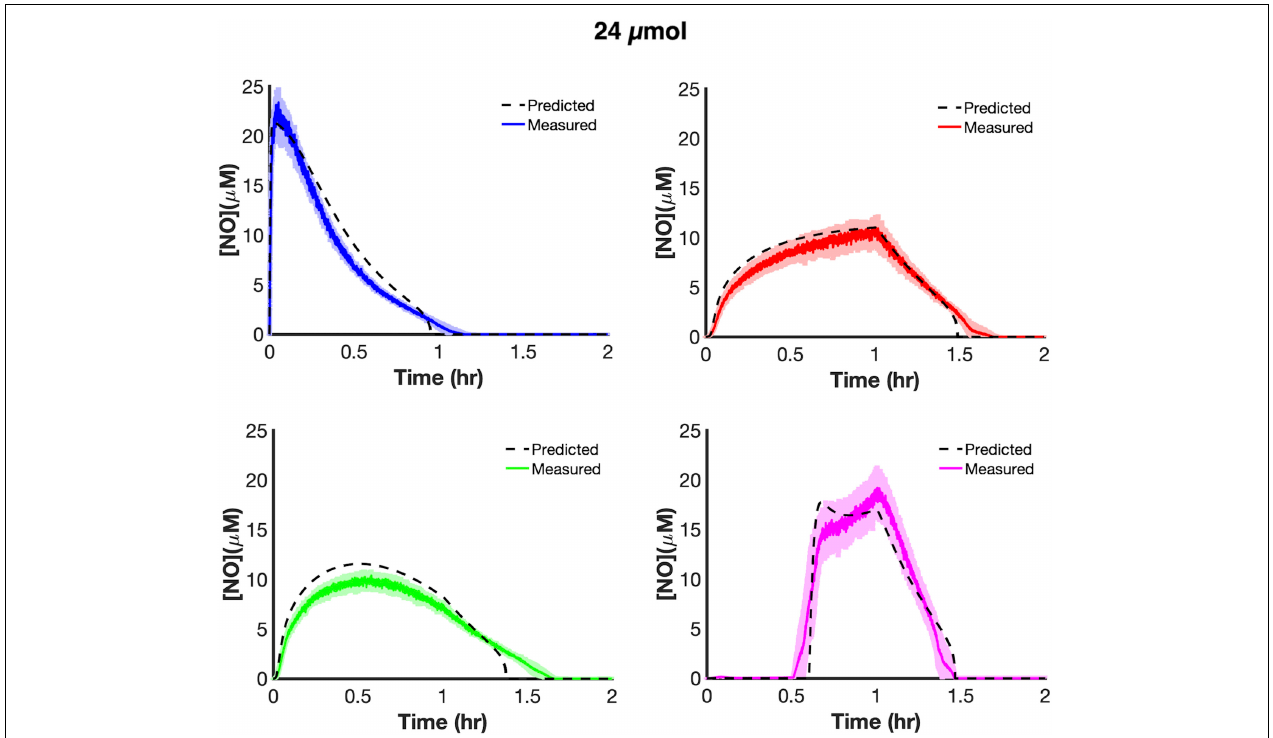
FIGURE 4 | Model extrapolation and predictions at 24 µ mol payloads. Dashed black lines represent predicted [NO] dynamics using the ensemble of parameter sets (ER < 10, 28 sets in total). Simulations from the ensemble members greatly overlapped, thus resembling a single line. Colored lines represent measured [NO] dynamics (bolus- blue; constant-red; ramp down-green; ramp up-pink). The solid lines represent the mean of three independent experiments, whereas the lightly shaded areas represent the standard error of the